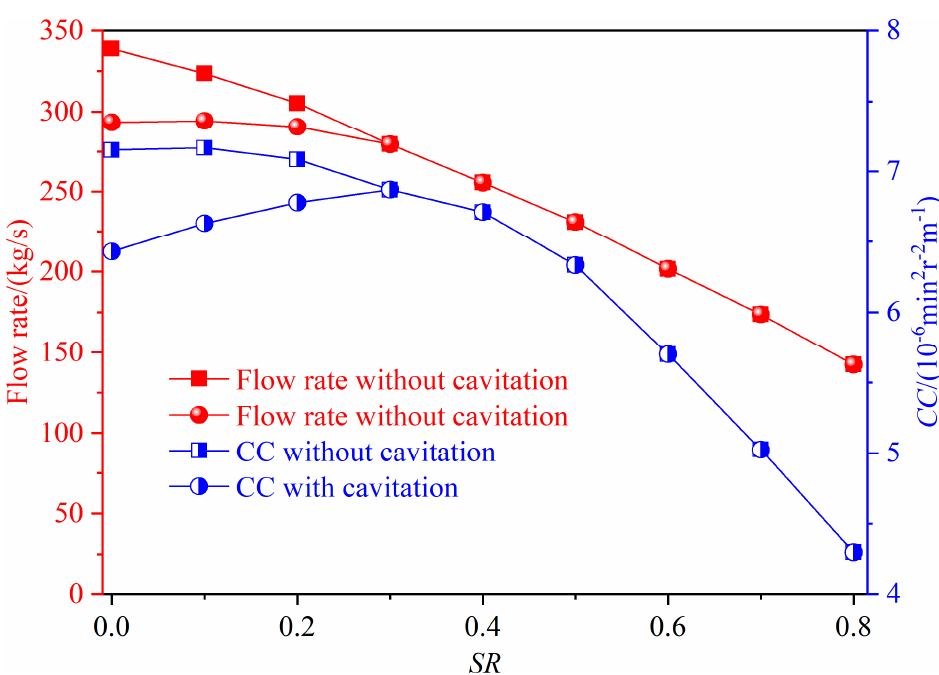
Figure 13. Mass flow rate and capacity constant caused by cavitation at various SRs .